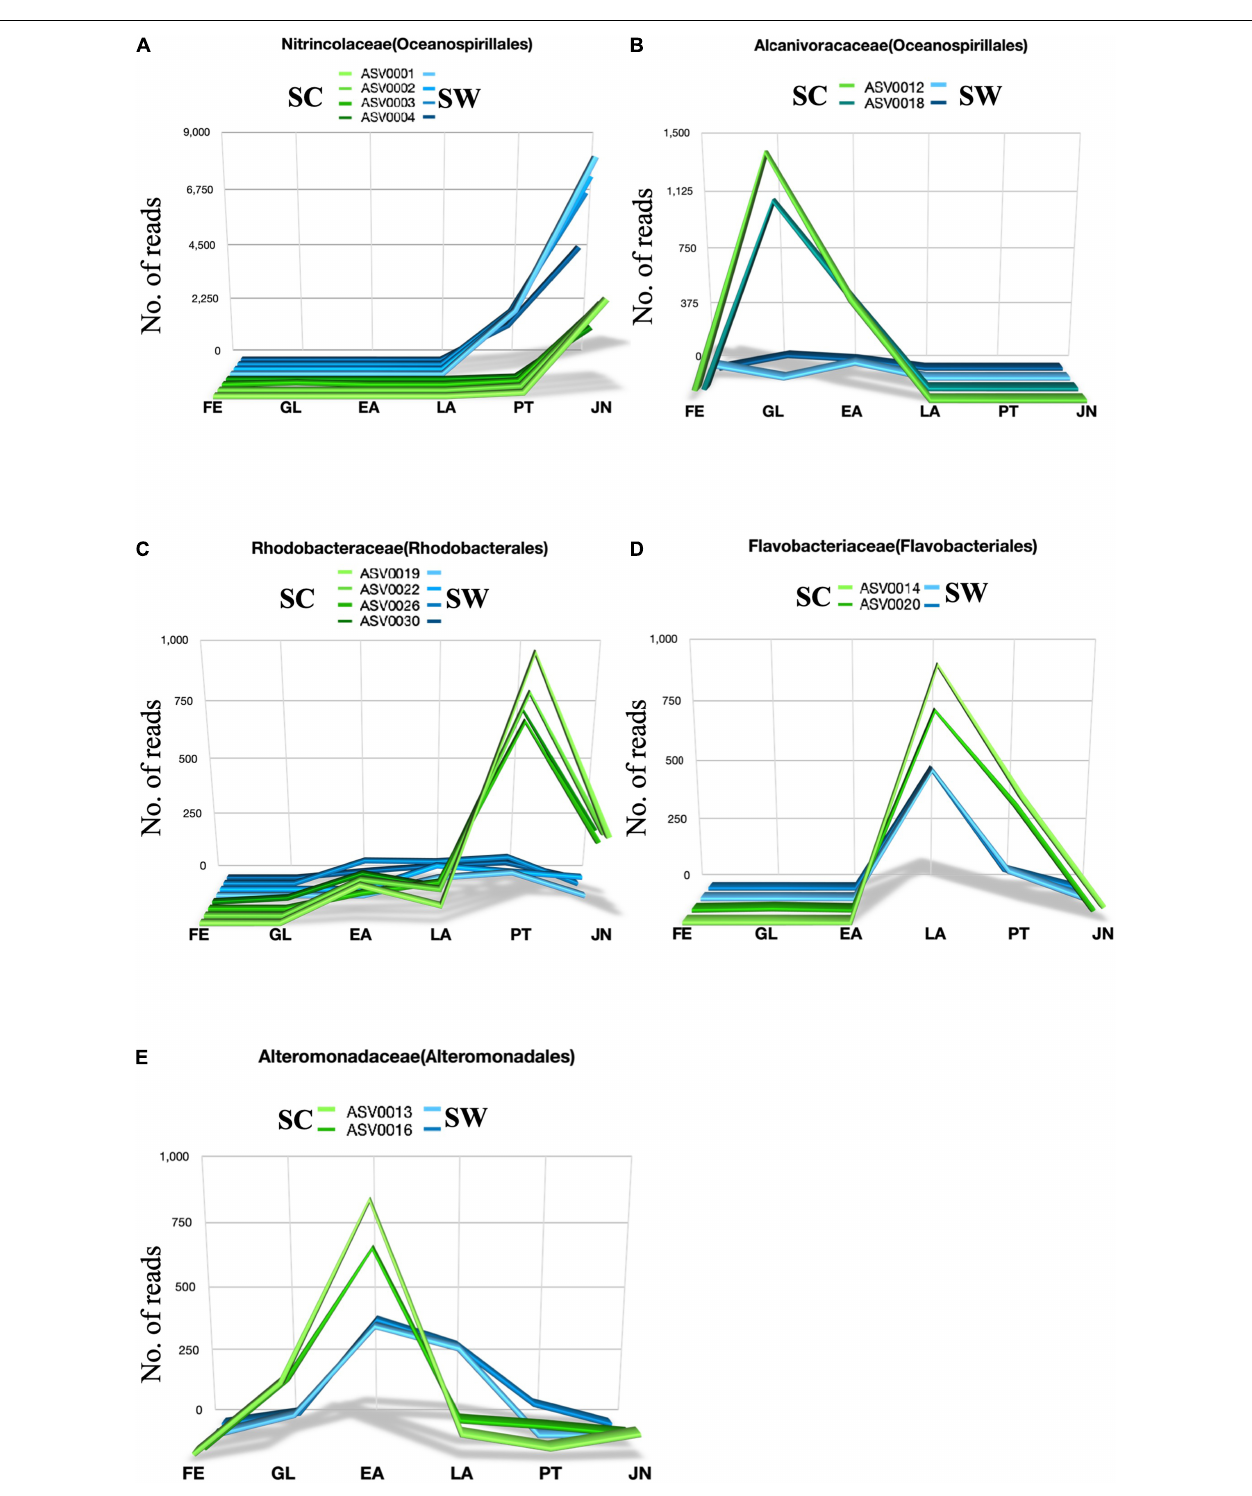
FIGURE 7 | Dynamics of relative abundance of key ASVs based on heatmap. 14 key ASVs were shown in panels (A–E) , respectively. X axis is developmental stage, and Y axis is number of reads. FE, Fertilized egg group; GL, Gastrula group; EA, Early auricularia group; LA, Late auricularia group; PT, Pentactula group; JN, Juvenile